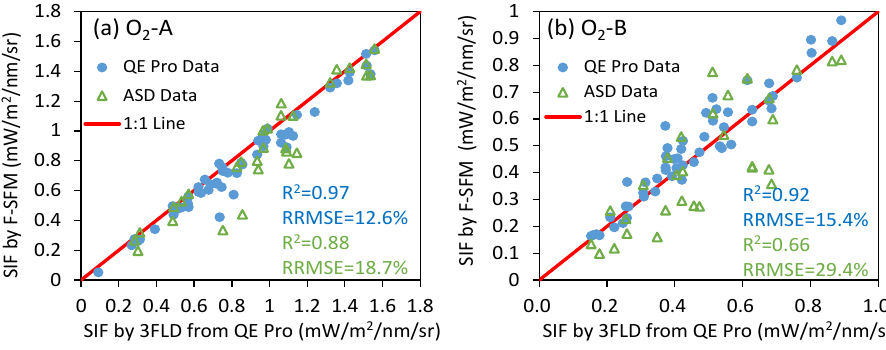
Figure 10. Comparison between the SIF retrieved by 3FLD using data obtained by the QE Pro and the SIF retrieved by F-SFM using data obtained by the QE Pro (blue points) or ASD FieldSpec4 (green triangles). The graphs shown are for the SIF at the O 2 -A ( a ) and O 2 -B ( b )